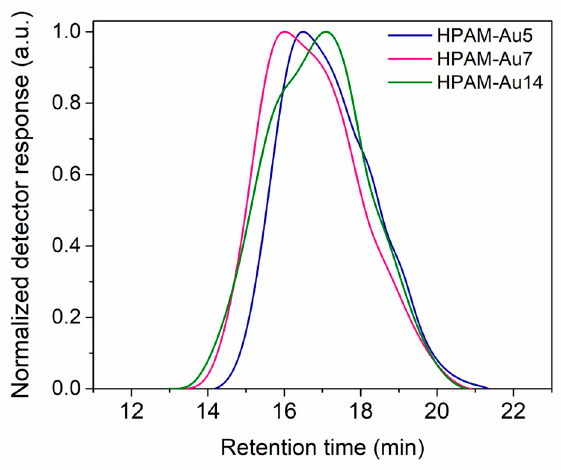
Figure 3. Molecular weight distribution by GPC of the HPAMs obtained at different pHs used to prepare the nanocomposites: HPAM-Au5 (acidic), HPAM-Au7 (neutral), HPAM-Au14